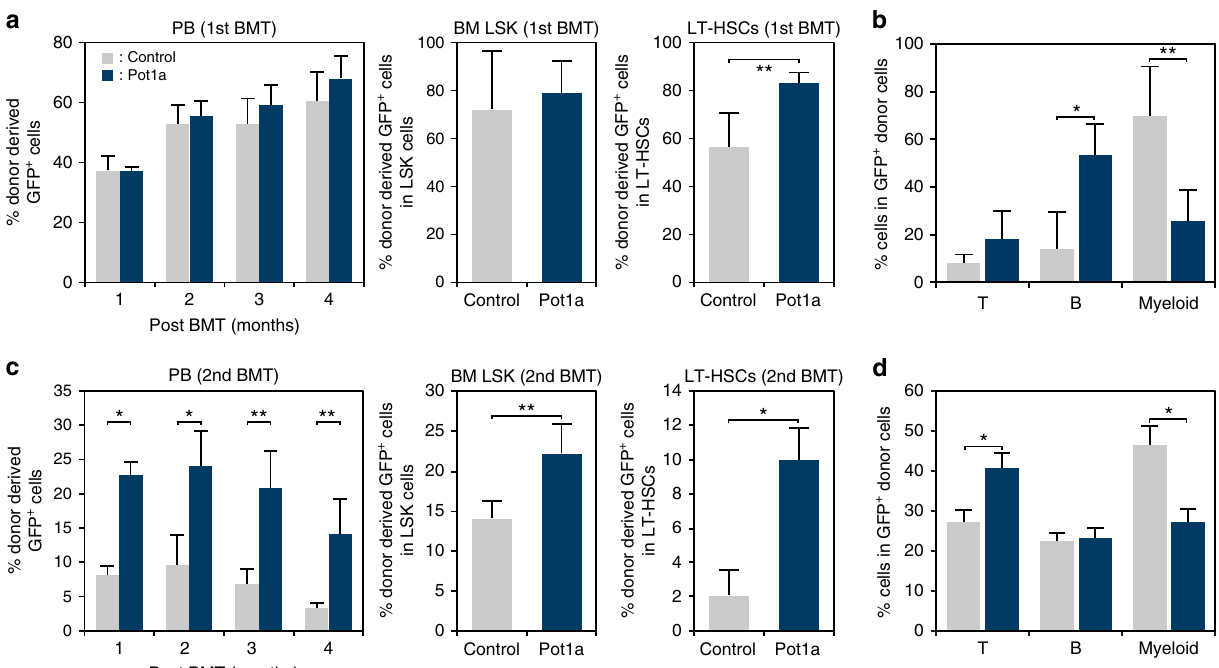
Fig. 3 Overexpression of Pot1a maintains HSC LTR activity. a , b Results of primary BMT. a Percentage of donor-derived (Ly5.1 + GFP + ) cells in recipient mice PB, BM LSK and LT-HSCs 4 months after BMT. b Peripheral blood analysis of B, T, and myeloid cell lineages 4 months post BMT. Data are expressed as the mean ± SD ( n = 5 group – 1 , ** p < 0.05 by t -test). Representative data from two independent experiments are shown. c , d Results of secondary BMT. c The percentage of donor-derived (Ly5.1 + GFP + ) cells in recipient mice PB, BM LSK and LT-HSCs 4 months post secondary BMT. d Peripheral blood analysis of B, T, and myeloid cell lineages 4 months post secondary BMT. Data are expressed as the mean ± SD ( n = 5, * p < 0.01 by t -test). Representative data from two independent experiments are